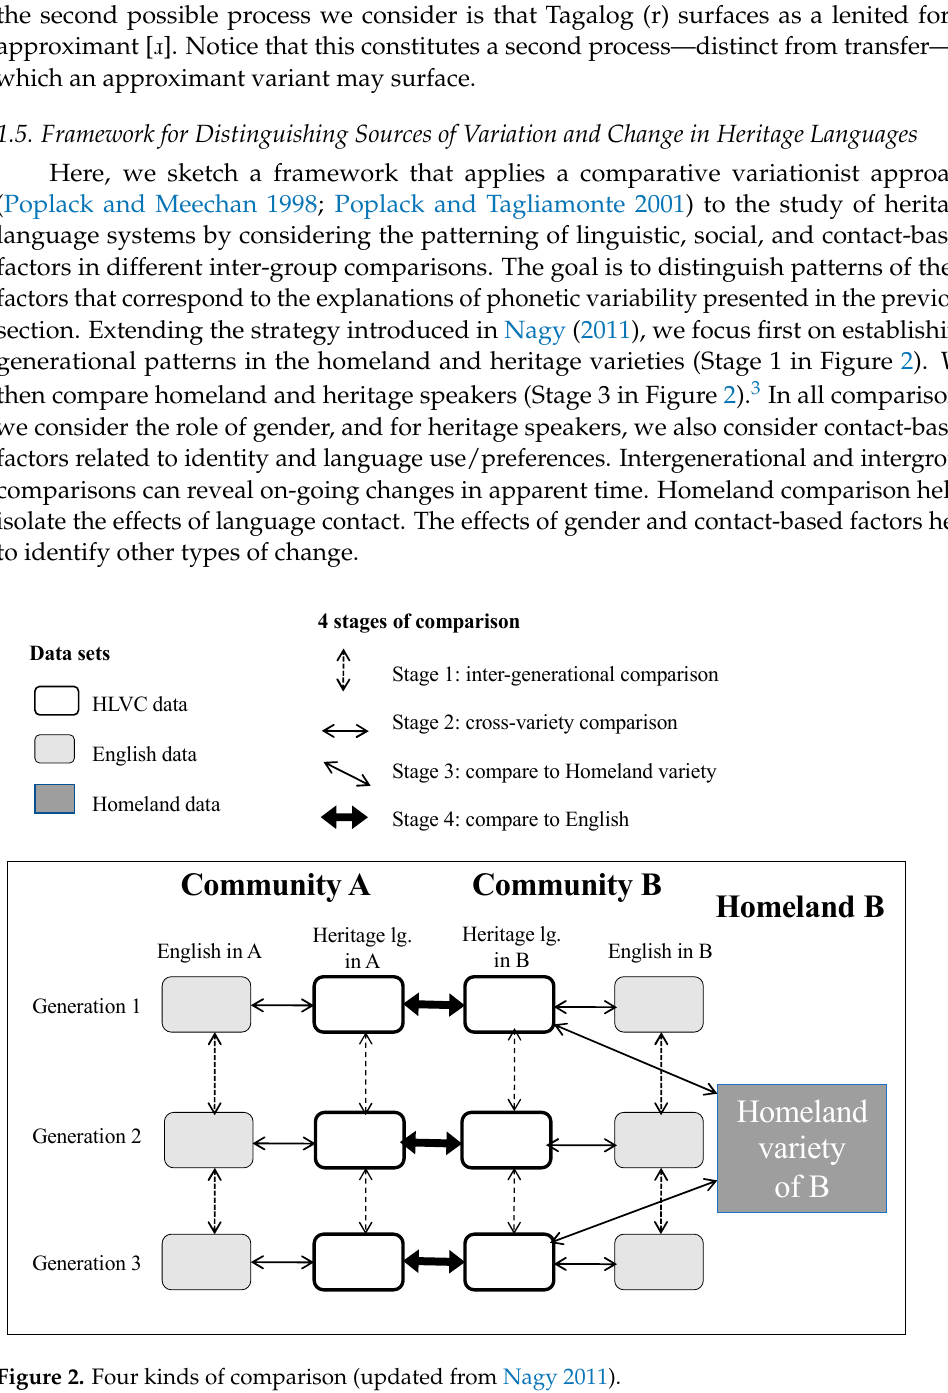
Figure 2. Four kinds of comparison (updated from Nagy 2011).